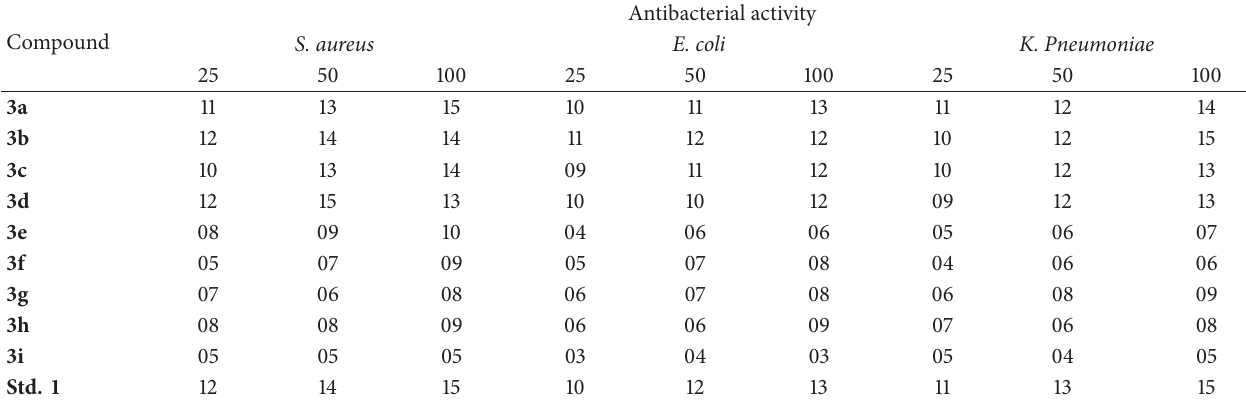
Std. 1: Gentamycin.